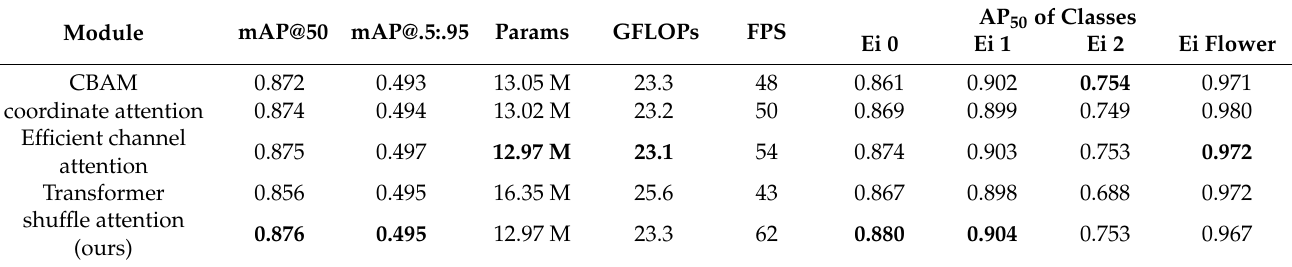
Table 4. Comparison of various modules added in efficient YOLOV5.